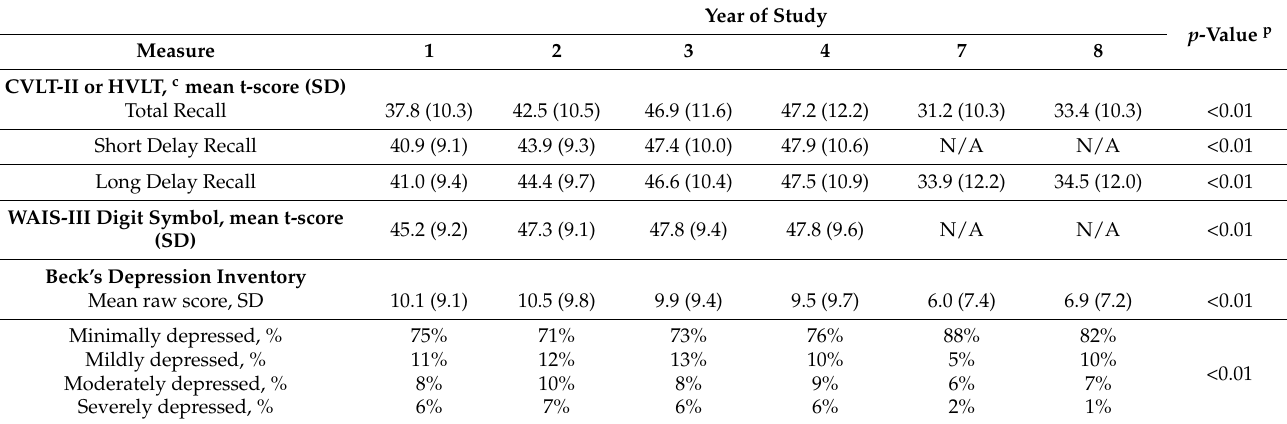
Table 2. Distribution of cognitive outcomes, by year of study (n =